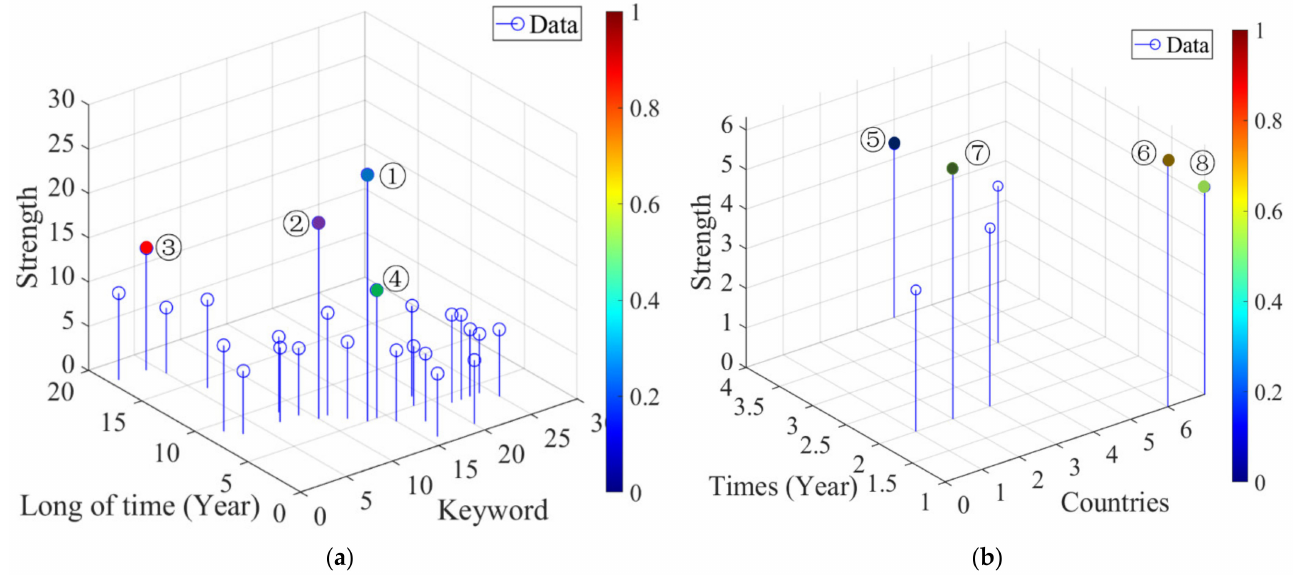
Figure 3. Literature clustering network analysis: ( a ) Keyword clustering network map analysis; ( b ) Institution and country clustering network map analysis (the node connection graph that highlights the main keywords, the higher the centrality and the higher the value of the